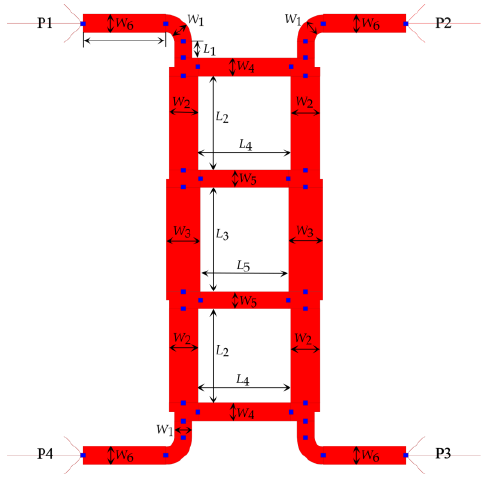
Figure 10. Layout of the type-2 crossover in ADS.